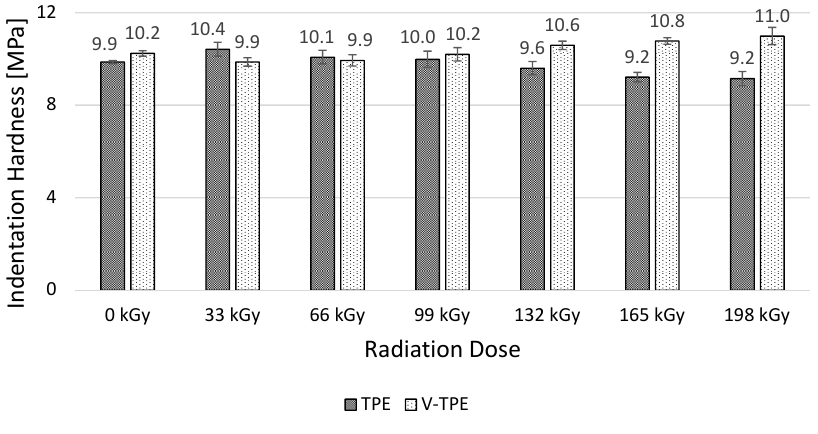
Figure 5. Micro-indentation hardness—TPE,